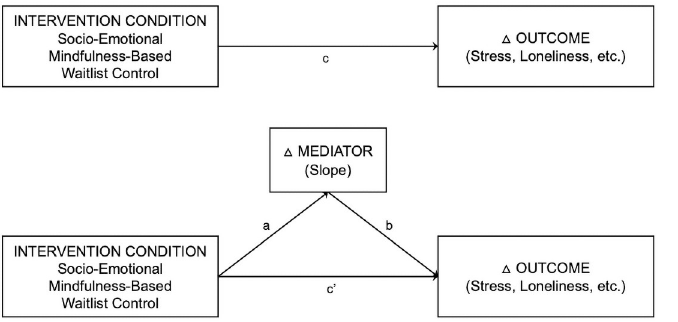
Fig 6. Graphical representation of the hypothesized mental training effects. 4 =